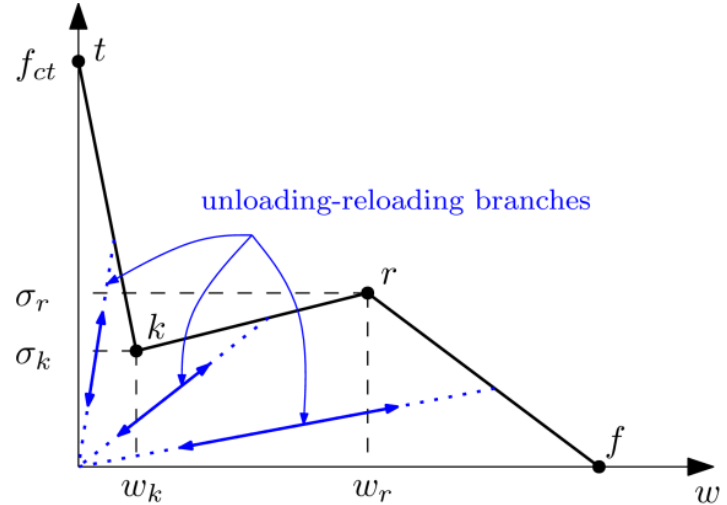
Figure 4. Trilinear diagram proposed by the authors for PFRC.